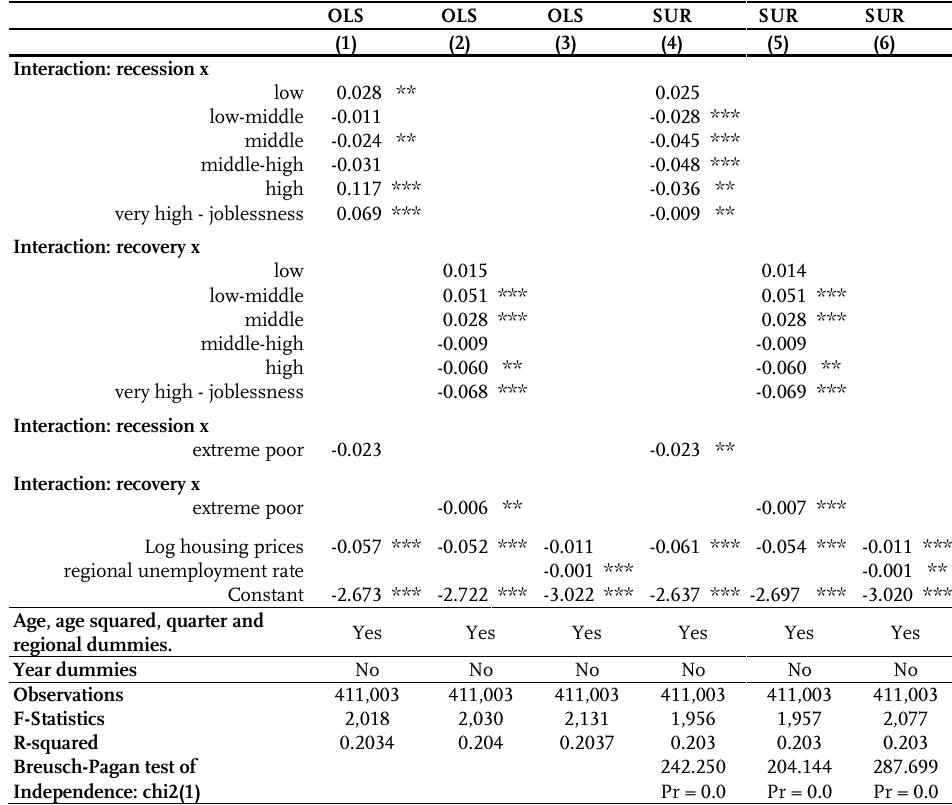
Table 3b: OLS and Seemingly Unrelated Regression results on emancipation